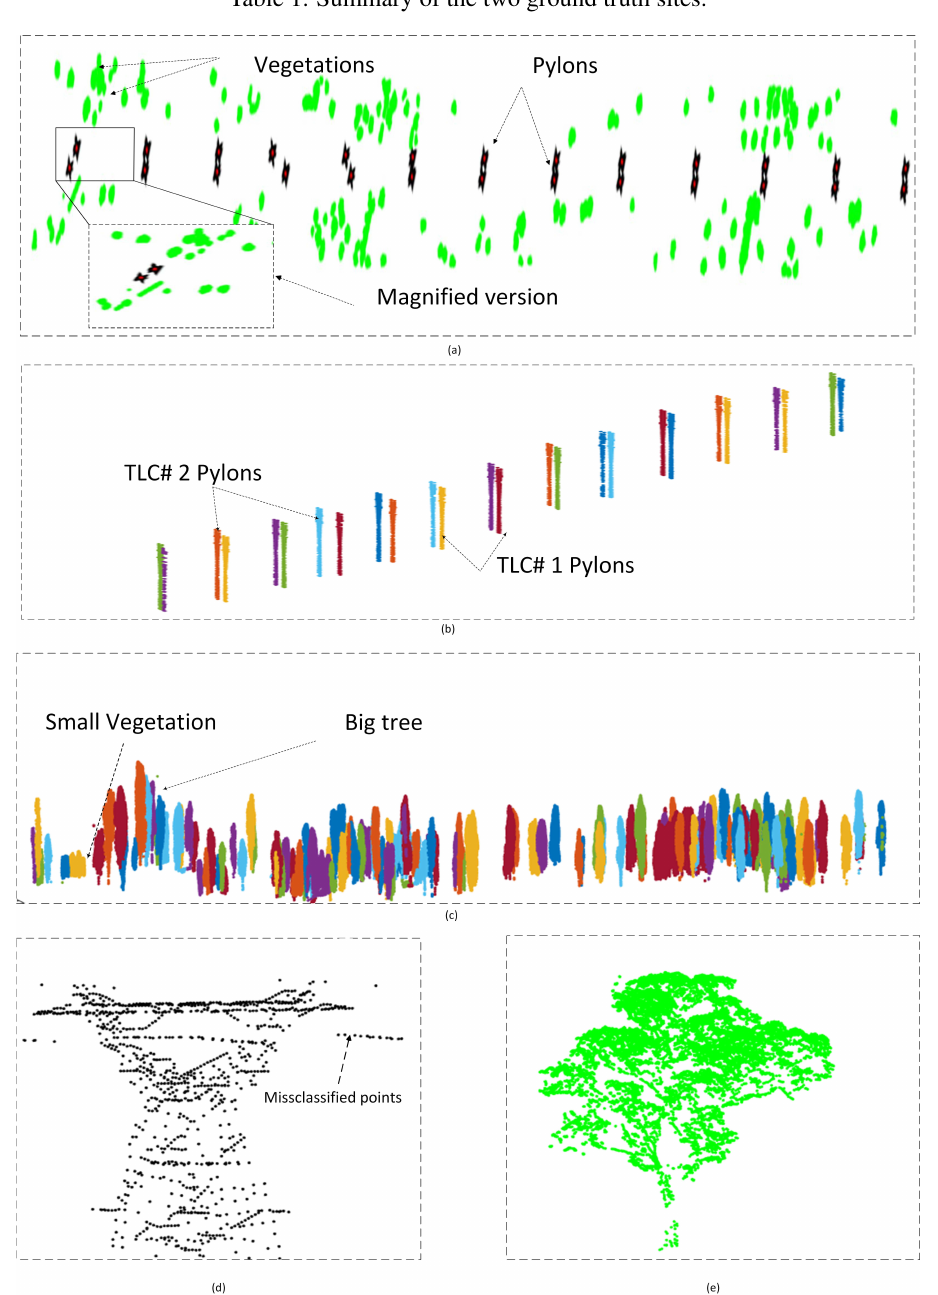
Table 1. Summary of the two ground truth